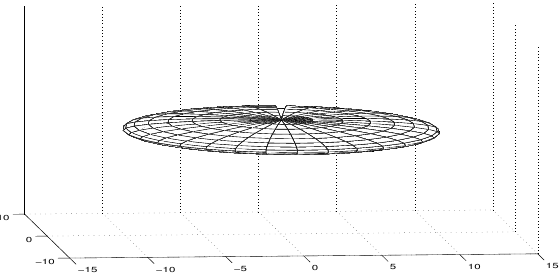
Figure 1. Disk-like core of the KN electron model is defined unambiguously by form of the Kerr- Newman metric and Kerr’s ellipsoidal coordinate